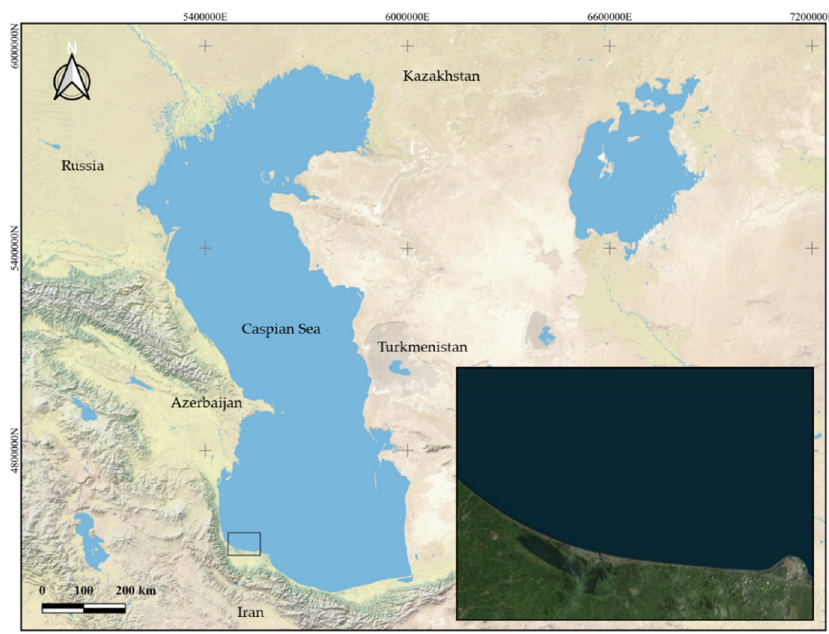
Figure 1. Sampling zone location on the southern coast of the Caspian Sea.